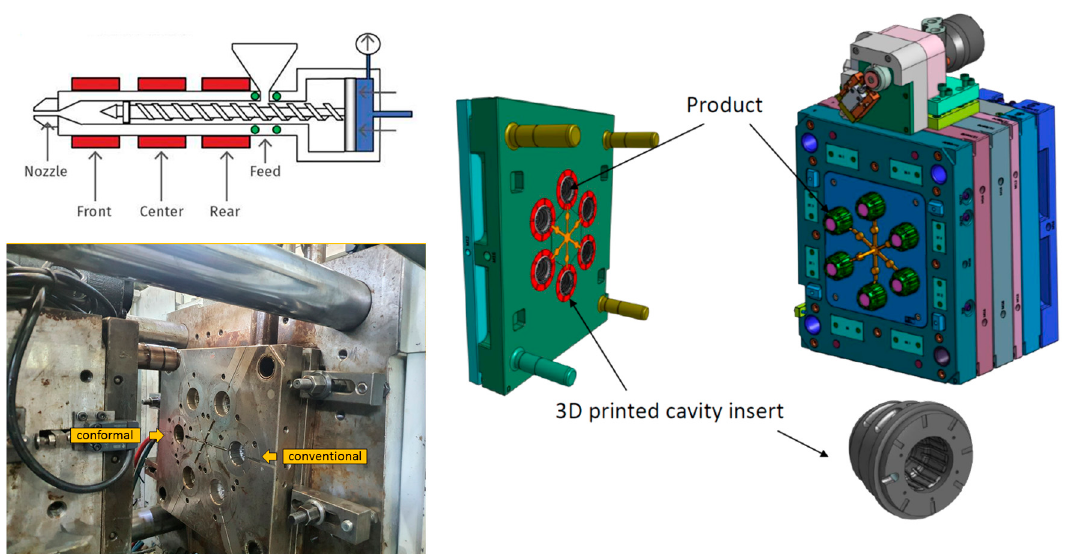
Figure 9. Schematic cross-section view of the feeding process (top left), injection mould system including the stationary platen with mould inserts, polymer products and movable platen with mould threads (right) and injection moulding machine setup with alternate using of conformal and convectional mould inserts on a 6 series production mould as used by Elysee Irrigation Ltd.